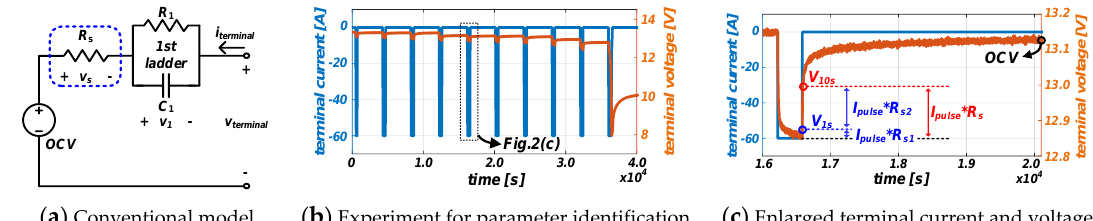
Figure 2. Equivalent circuit model and experiment profile for parameter identification.